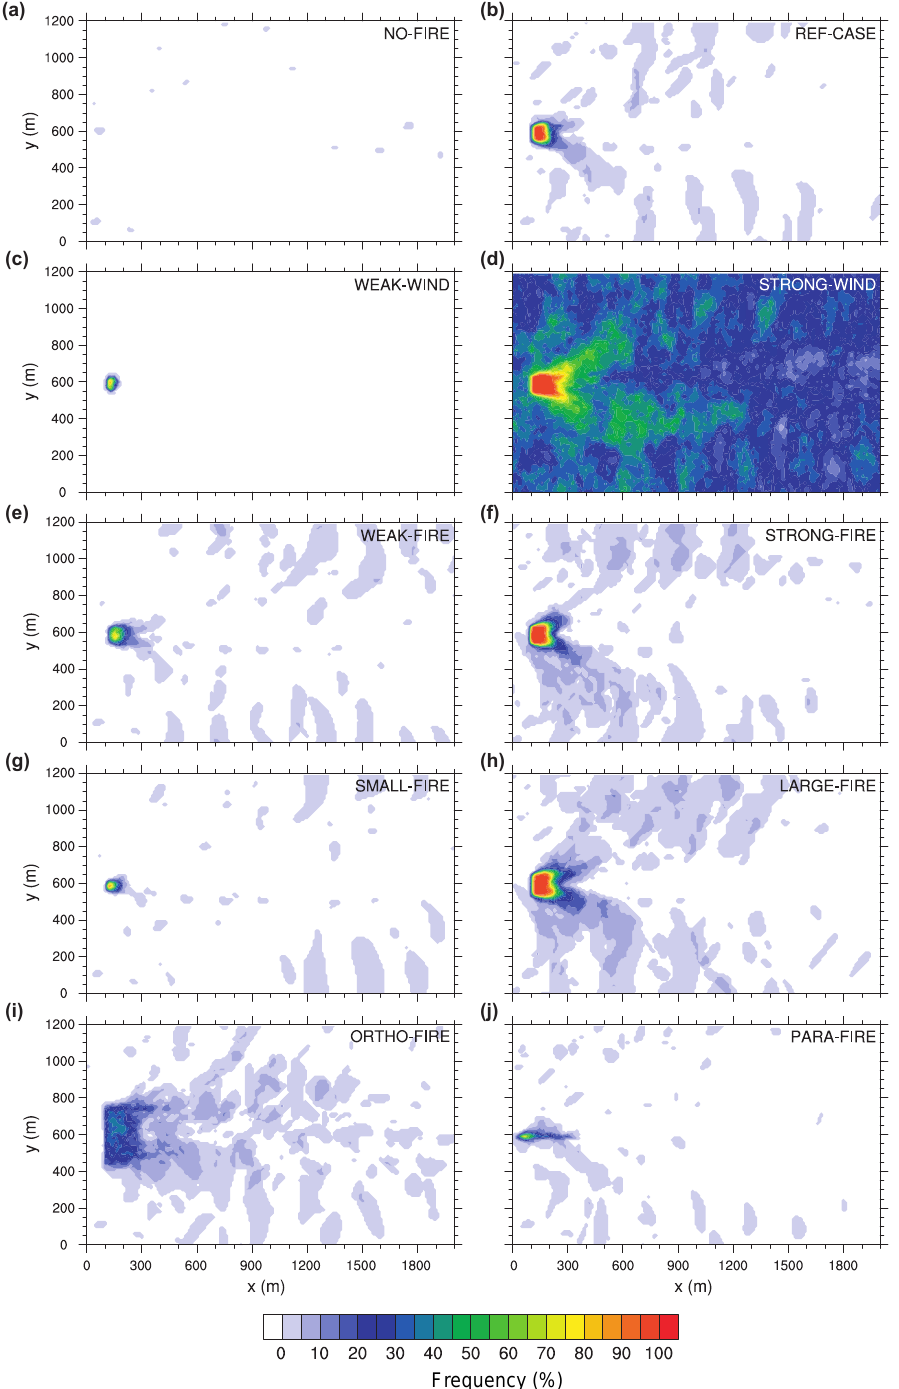
Figure 9. Spatial distribution of areas where a typical threshold velocity v tres of 6ms − 1 is exceeded in the lowest model level. Shown is the frequency of occurrence of such wind velocities per grid